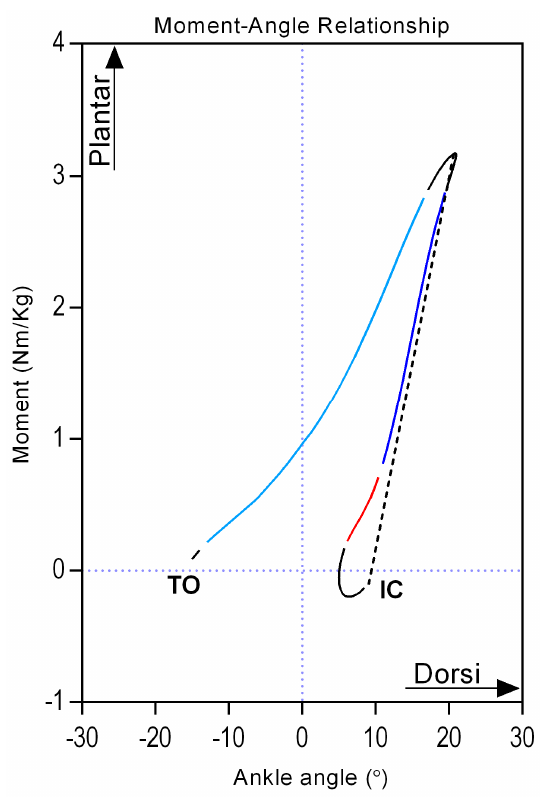
Figure 1. Example of moment–angle loop for the ankle joint. IC = initial foot contact; TO = toe off. Dashed line represents commonly computed slope for ankle stiffness during the loading phase. Red line represents foot / ground initial loading; blue line represents loading phase; light-blue line represents unloading phase.